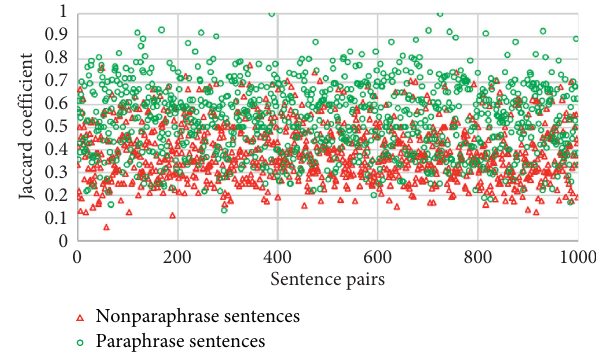
Figure 1: Comparisons of lexical similarity between paraphrase pairs and nonparaphrase pairs.